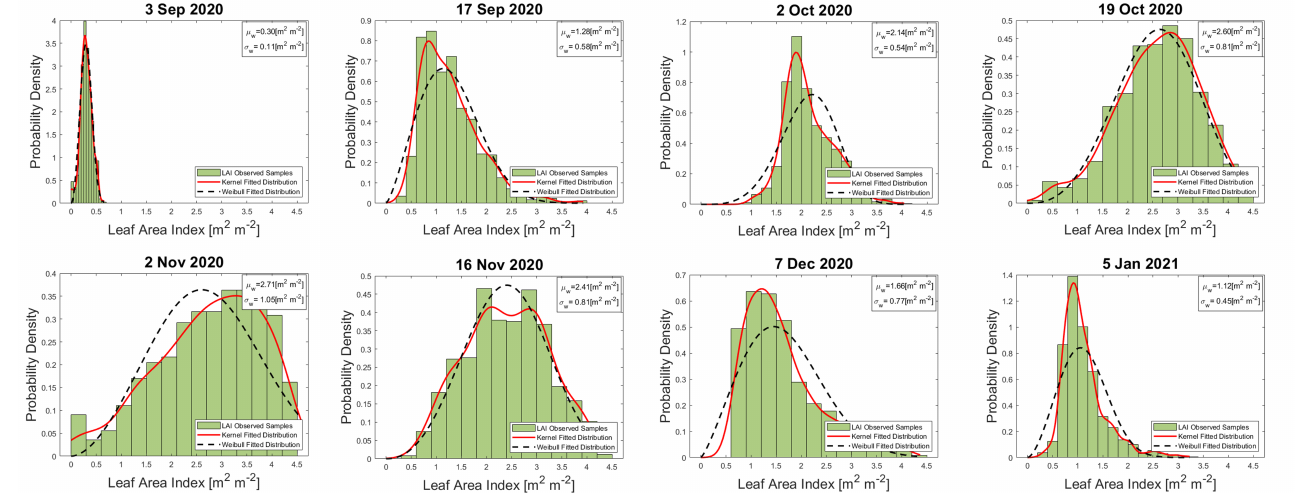
Figure 9. Temporal evolution of probability density function of LAI (m 2 m − 2 ) for the winter wheat paddocks 321, 323, and 323 at the study site. LAI observed samples in each graph correspond to S1-derived LAI